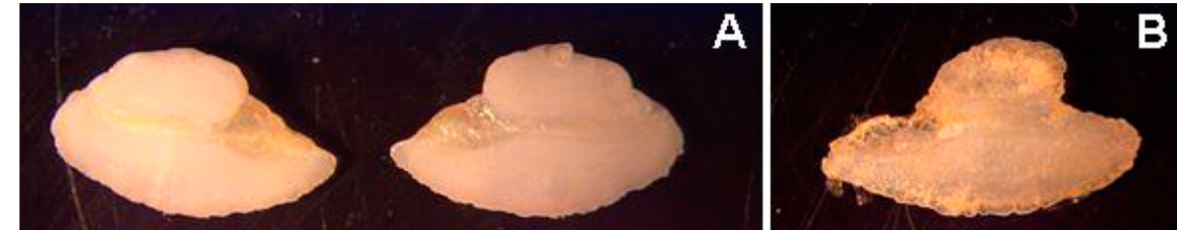
Figure 20. LM. ( A ) Left and right otolith composed entirely of aragonite . ( B ) Right otolith composed basically of vaterite.